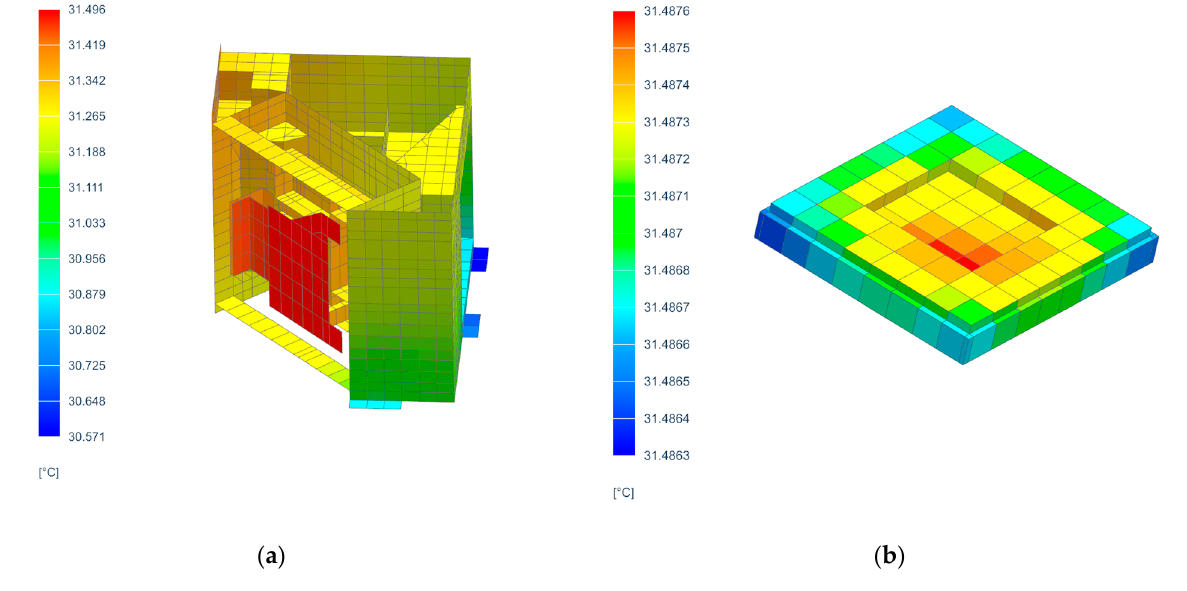
Figure 12. Temperature clouds of CMOS components in the high-temperature case (( a ). Heat dissipation component; ( b ). CMOS).